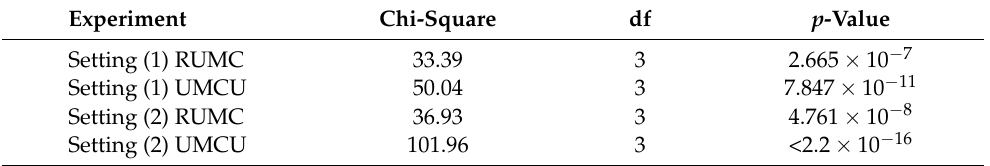
Table A7. Friedman rank sum test for each of the settings and centers used.